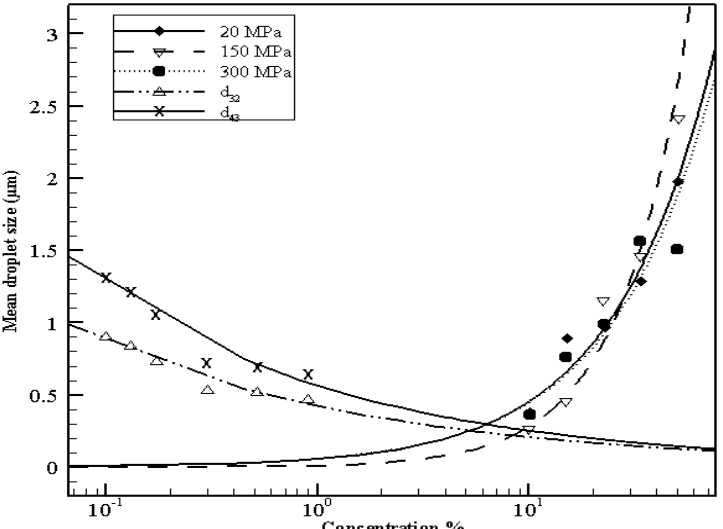
Figure 6: Mean droplet size in emulsions homogenized at 20, 150 and 300 MPa against oil concentration in percentage (%) [11,